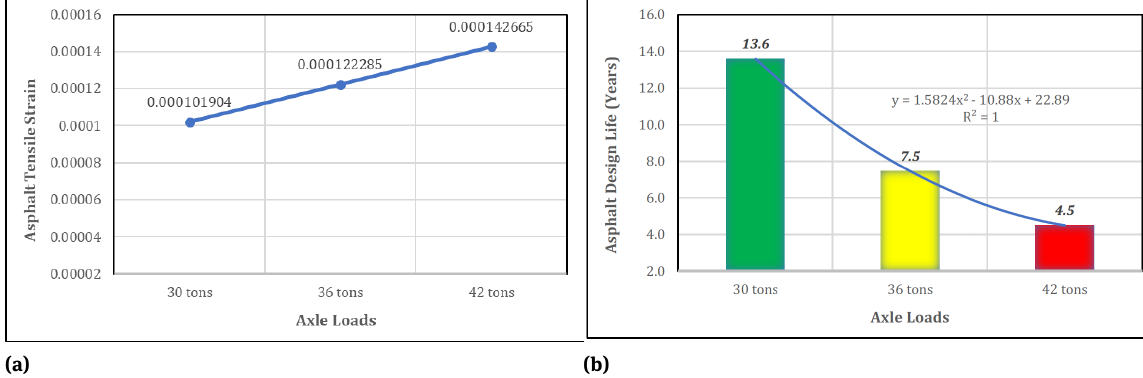
phalt tensile strains are increased by 20% and 17%